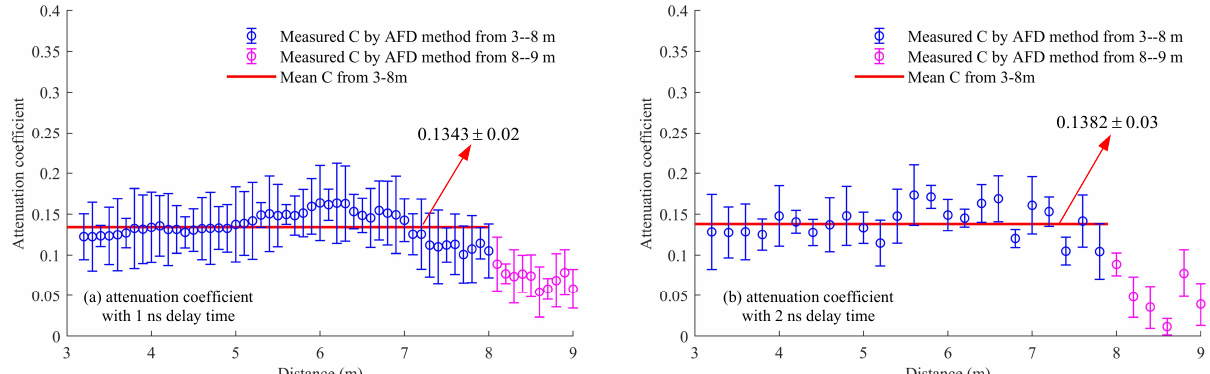
Figure 7. Attenuation coefficient at 3–9 m in water body measured by the AFD method with different delay step times. ( a ) the delay step time is 1 ns and ( b ) the delay step time is 2